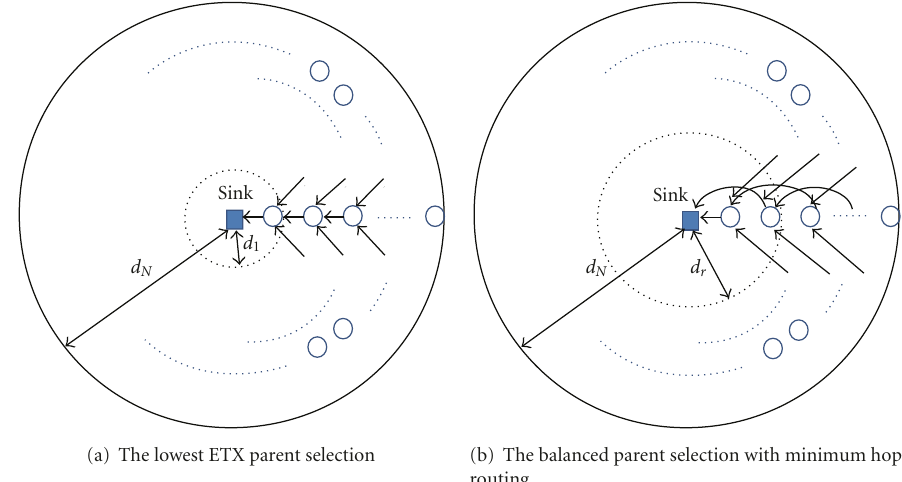
Figure 12: The maximum energy consumption as the number of nodes in a hop ( r ).